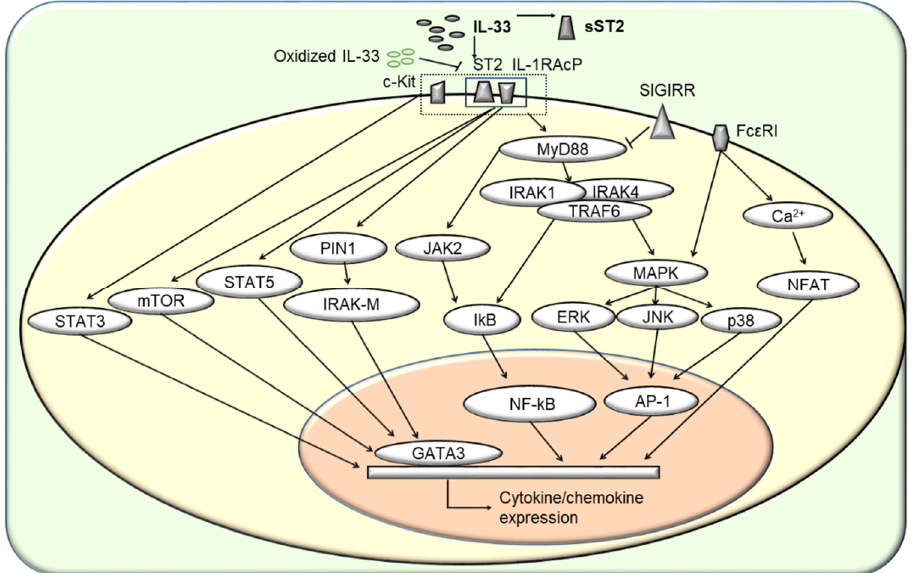
Figure 2. The intracellular signaling pathway of IL-33R. When IL-33 binds to ST2, IL-1RAcp is recruited to form a ligand-receptor complex, generating the minimum IL-33 receptor complex. The complex binds to the intracellular TIR domain and activates IRAK1, IRAK4, MyD88, and TRAF6. IRAKs induce the phosphorylation and degradation of I κ B- α to generate NF- κ B, subsequently activating the MAPK signaling pathway, which involves ERK1/2, P38, and JNK, and activator protein 1 (AP-1). Transcription factors NF- κ B and AP-1 induce target gene expression in response to IL-33. Except for the classic shared mechanism of the IL-1R family, IL-33 interacts with IL-2, IL-7, and TSLP to mediate gene expression in a STAT5-dependent manner. In mast cells, the formation of this receptor complex also requires the presence of c-kit. Fc E R1 and ST2 jointly activate nuclear factor of activated T cells (NFAT) by mobilizing intracellular Ca 2+ . In mouse peritoneal macrophages,